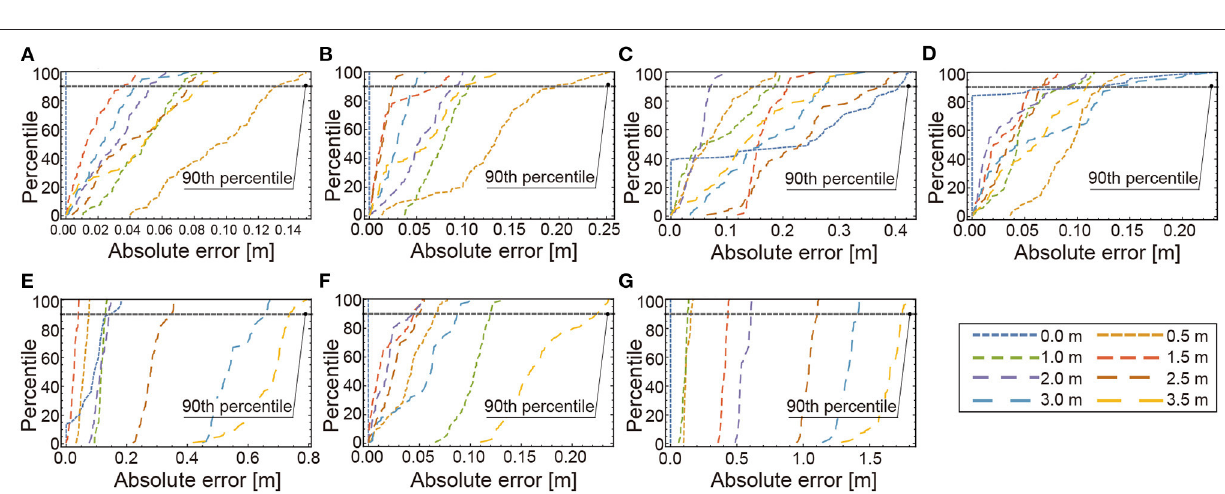
d 0 could not be estimated correctly. When the ISO value was set over 300, estimations at the centimeter level were achieved. We also found that SSs should be shortened. However, SSs that are too short make estimation difficult because the images become too dark. Hence, the settings of the camera suggest that